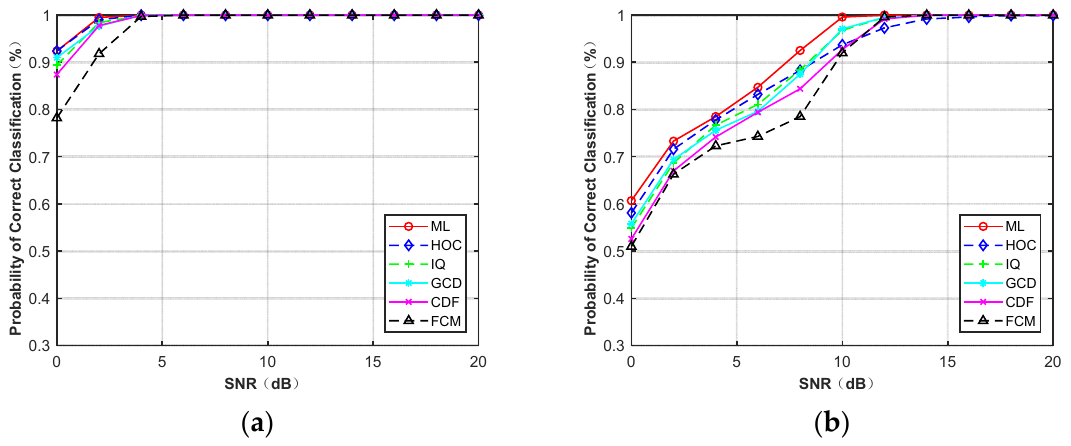
Figure 7. Probability of correct classification under AWGN (N = 512). ( a ) MPSK. ( b ) MQAM